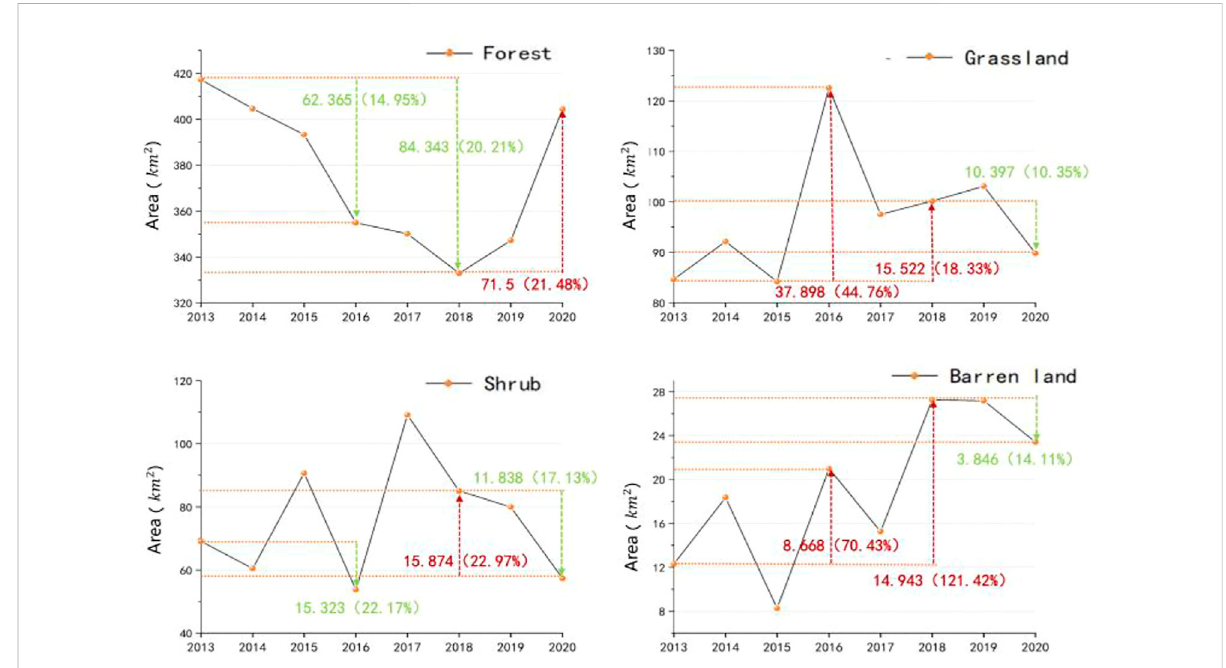
FIGURE 3 Main land cover changes in the Jiuzhaigou Nature Reserve.